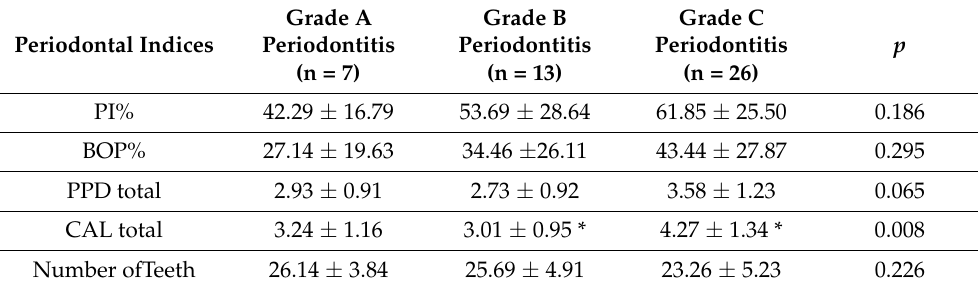
Table 5. Periodontal indices in patients with grade A, B and C periodontitis.